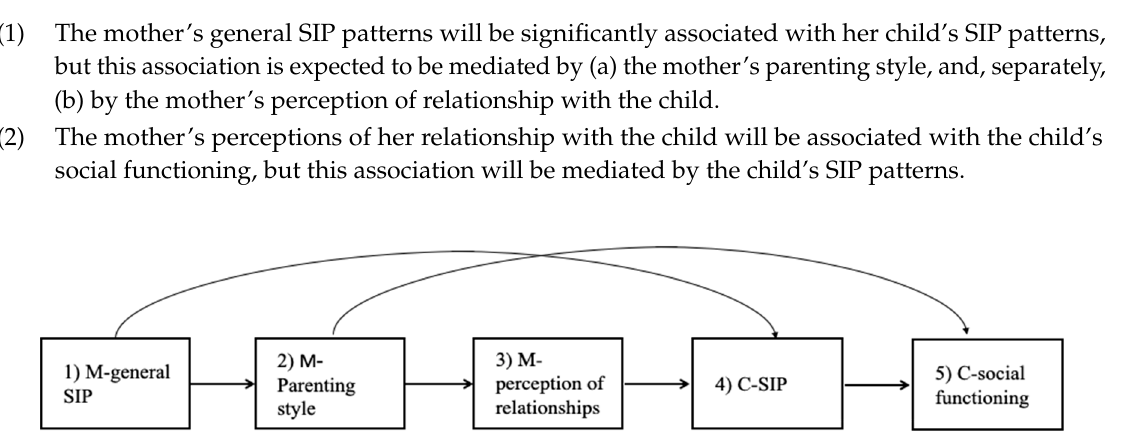
Table 1. Descriptive statistics and correlations for person-level averages of all study variables and covariates. Variable